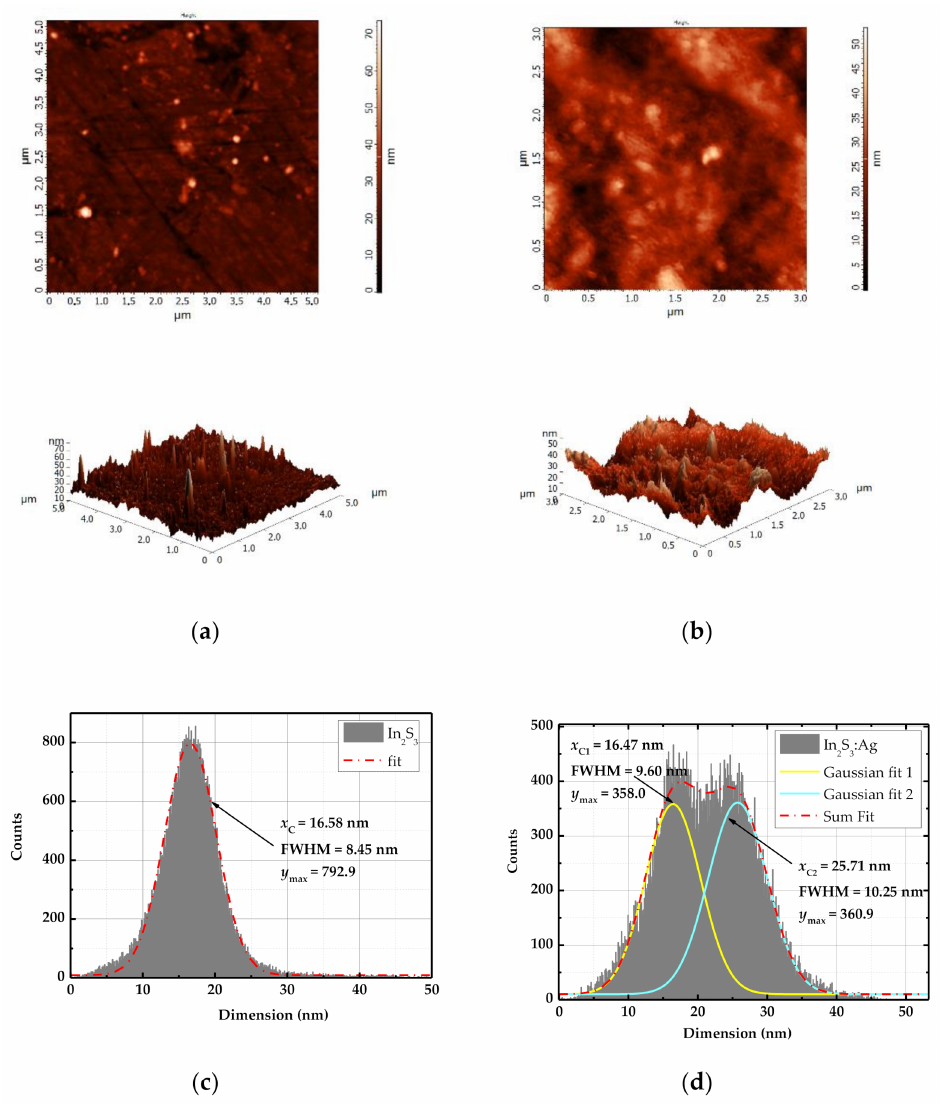
Figure 2. Results of atomic force microscopy (AFM) scans of the films: 2D and 3D non-contact (NC)-AFM images of samples ( a ) In 2 S 3 and ( b ) In 2 S 3 :Ag; distribution of columns sizes of samples ( c ) In 2 S 3 and ( d ) In 2 S 3